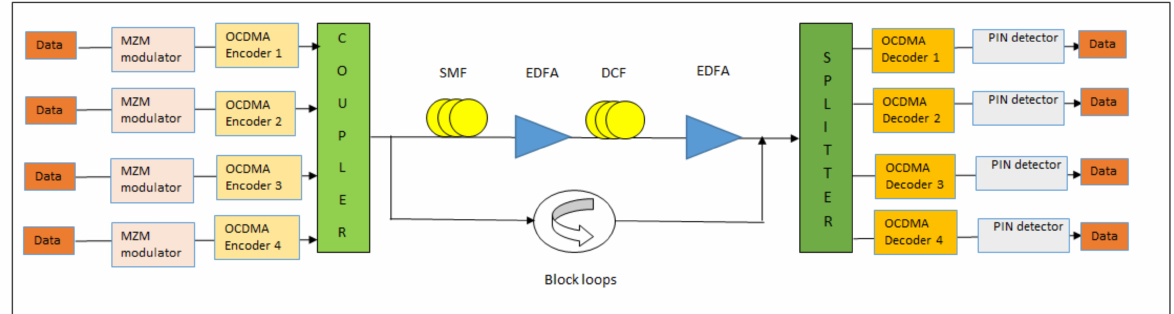
Figure 1. Proposed 2D-MD SAC-OCDMA system architecture (MZM: Mach-Zehnder modulator, EDFA: Erbium-doped fiber amplifier, SMF: Single mode Fiber, DCF: Dispersion compensating